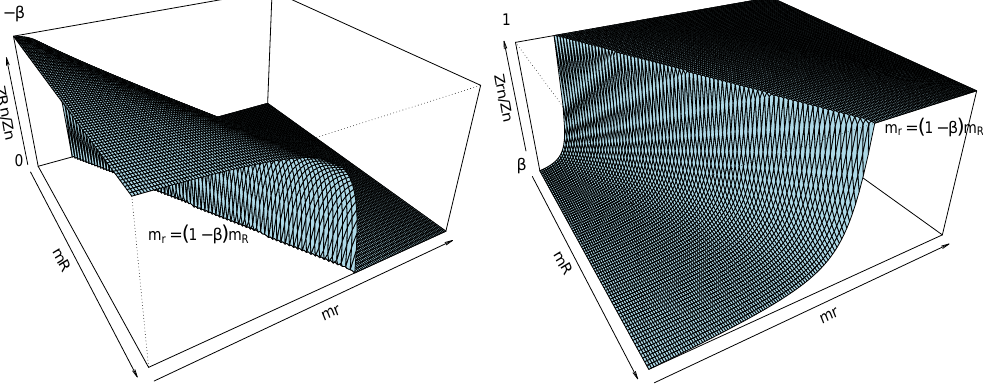
Figure 1. Limiting genotype frequency for R -allele ( left ) and for r -allele ( right ), depending on m R and m r , for fixed β